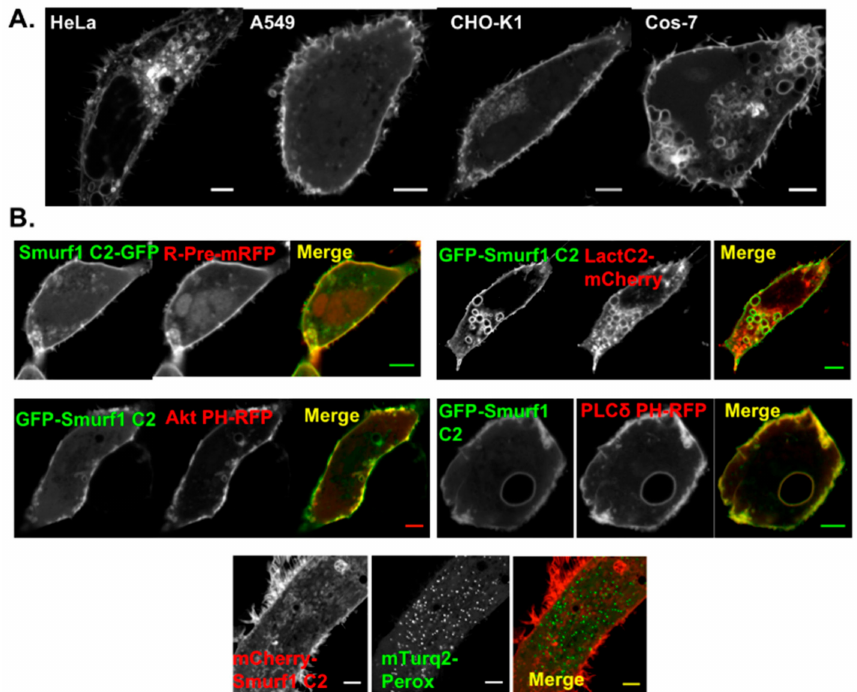
Figure 3. The Smurf1 C2 domain localizes to the plasma membrane and intracellular membranes. Cell lines were transfected with Smurf1 C2 fluorescent fusion constructs to analyze cellular membrane localization. ( A ) GFP-Smurf1 C2 was introduced into HeLa, A549, CHO-K1 and COS-7 cells. Intracellular vesicle localization was observed in all cell types in addition to consistent plasma membrane localization. The Smurf1 C2 domain was also detected in cellular protrusions ( n ≥ 20 for all cell types). ( B ) In CHOK-1 cells, the GFP-Smurf1 C2 domain co-localizes with R-Pre, a peptide that binds